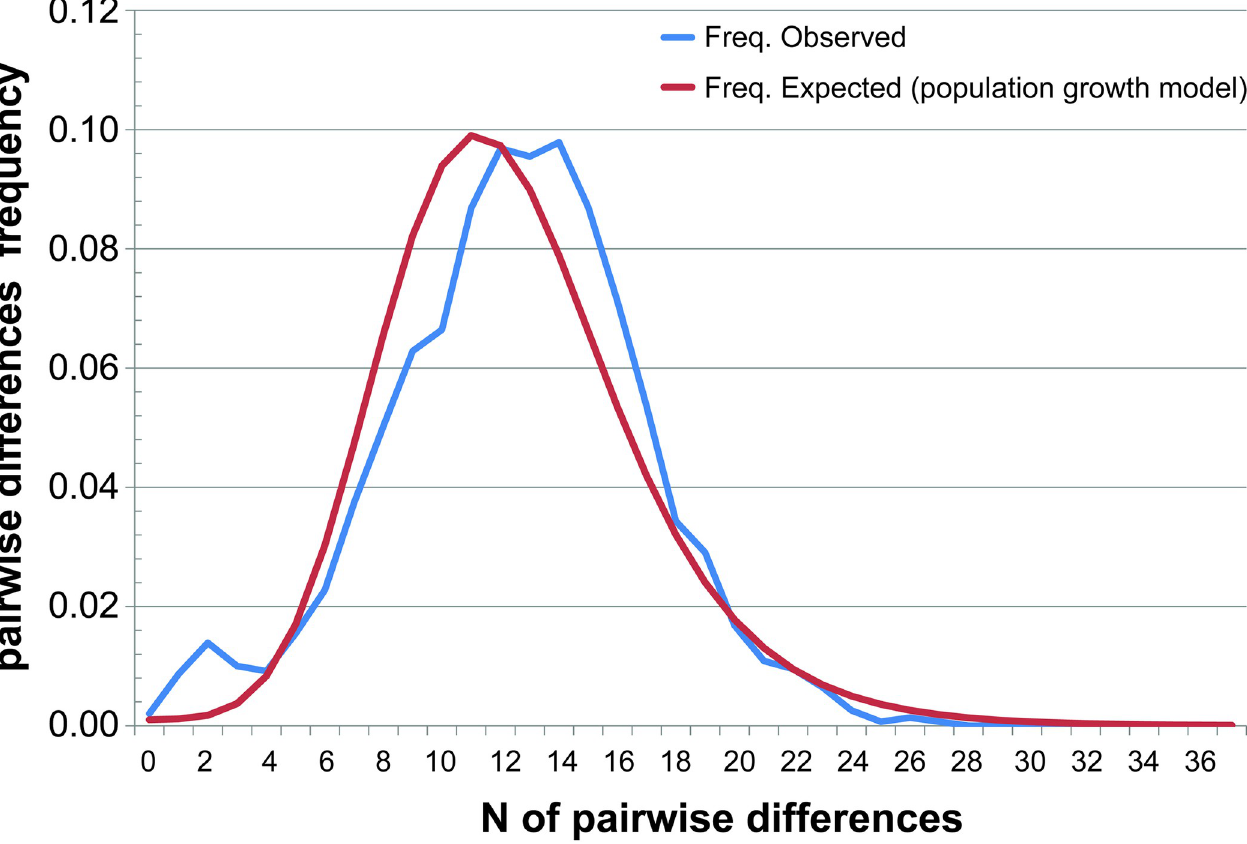
Fig 4. Mismatch distribution analysis for concatenated sequences of A . agrarius from the Western part of the range.